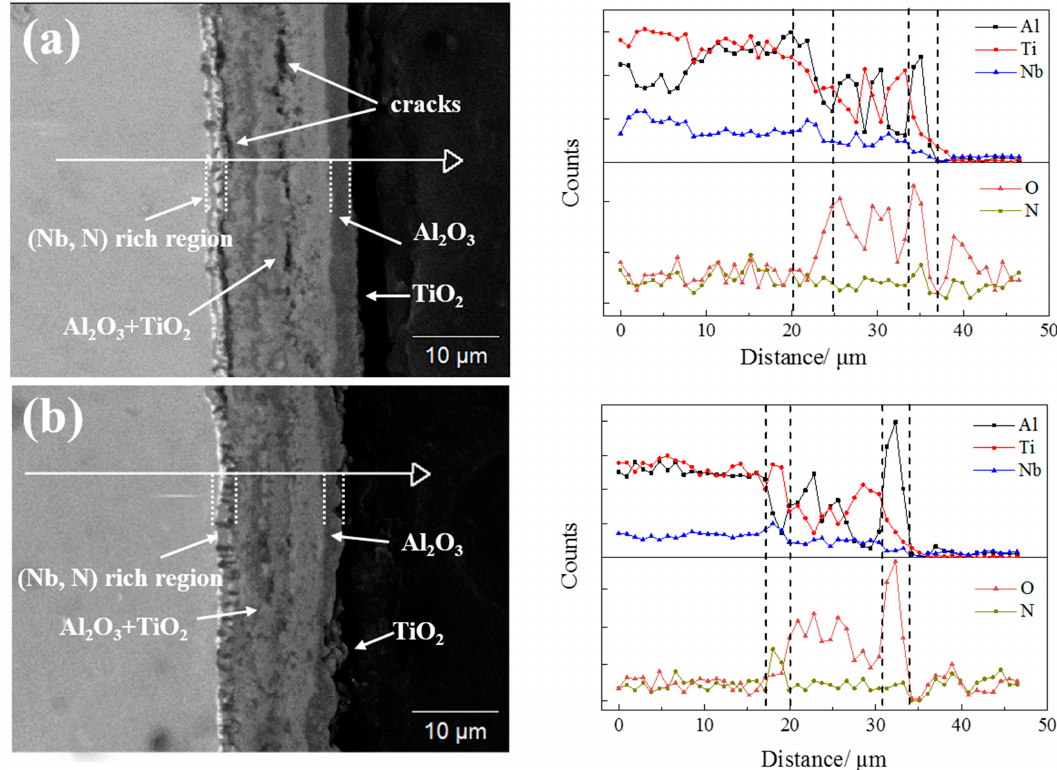
Figure 13. The cross-section morphologies and EDS line scan profiles of the oxide layers of both alloys after isothermal oxidation at 900 °C for 100 h, ( a ) as-cast alloy, and ( b ) as-sintered alloy.